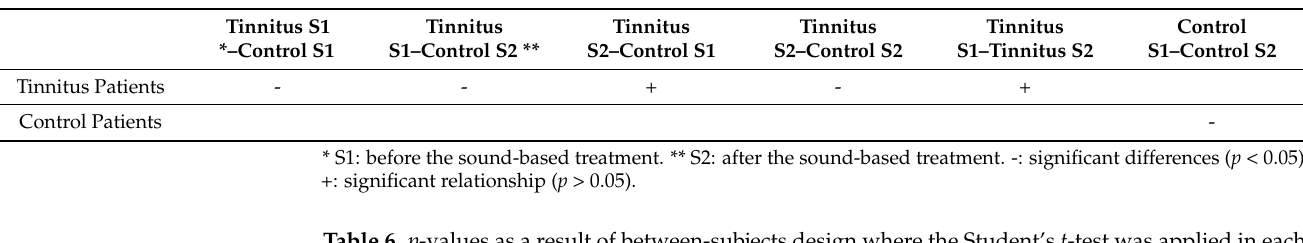
Table 5. p -values as a result of within-subjects design where the Student’s t -test was applied in tinnitus subjects versus control participants in different sessions undertaken before and after the sound-based treatment.